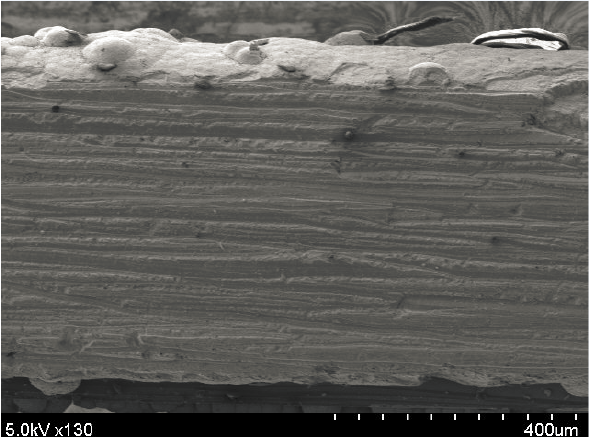
Figure 12. SEM image of the cross section of the 600- μ m-thick Bi 2 Te 3 film.